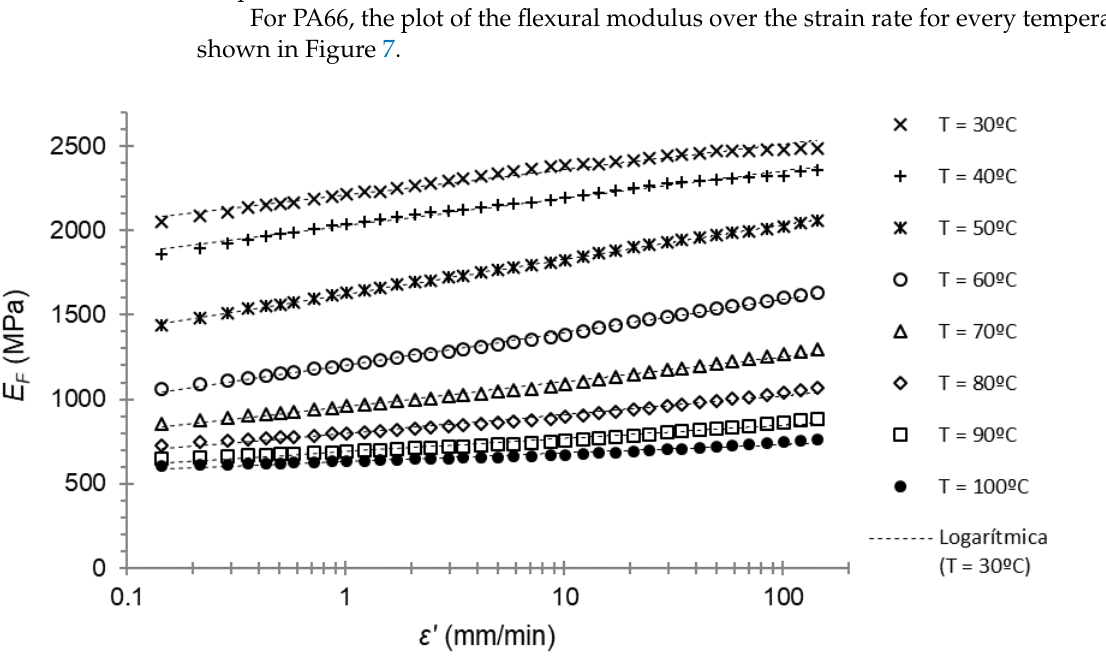
Table 1. Slope and independent terms of the logarithmic adjustment between flexural modulus and strain rate for